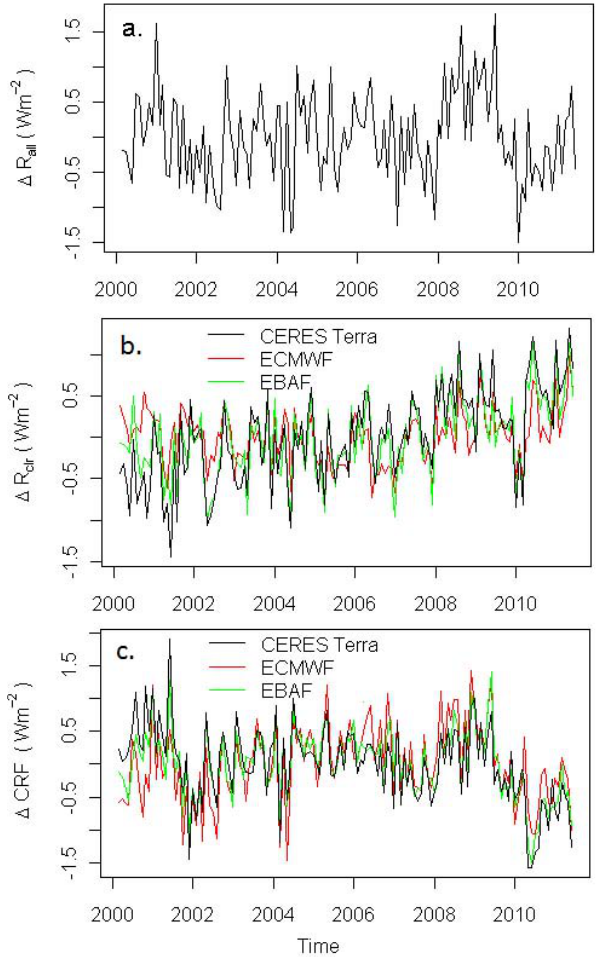
Fig. 1. (a) Global average monthly anomalies for all-sky TOA ra- diative flux from CERES measurements aboard the Terra satel- lite. (b) Global average monthly anomalies for clear-sky TOA radiative fluxes from CERES Terra, ECMWF ERA-Interim, and CERES EBAF. (c) The global average monthly CRF anoma- lies from CERES-only measurements, CERES-ECMWF, and